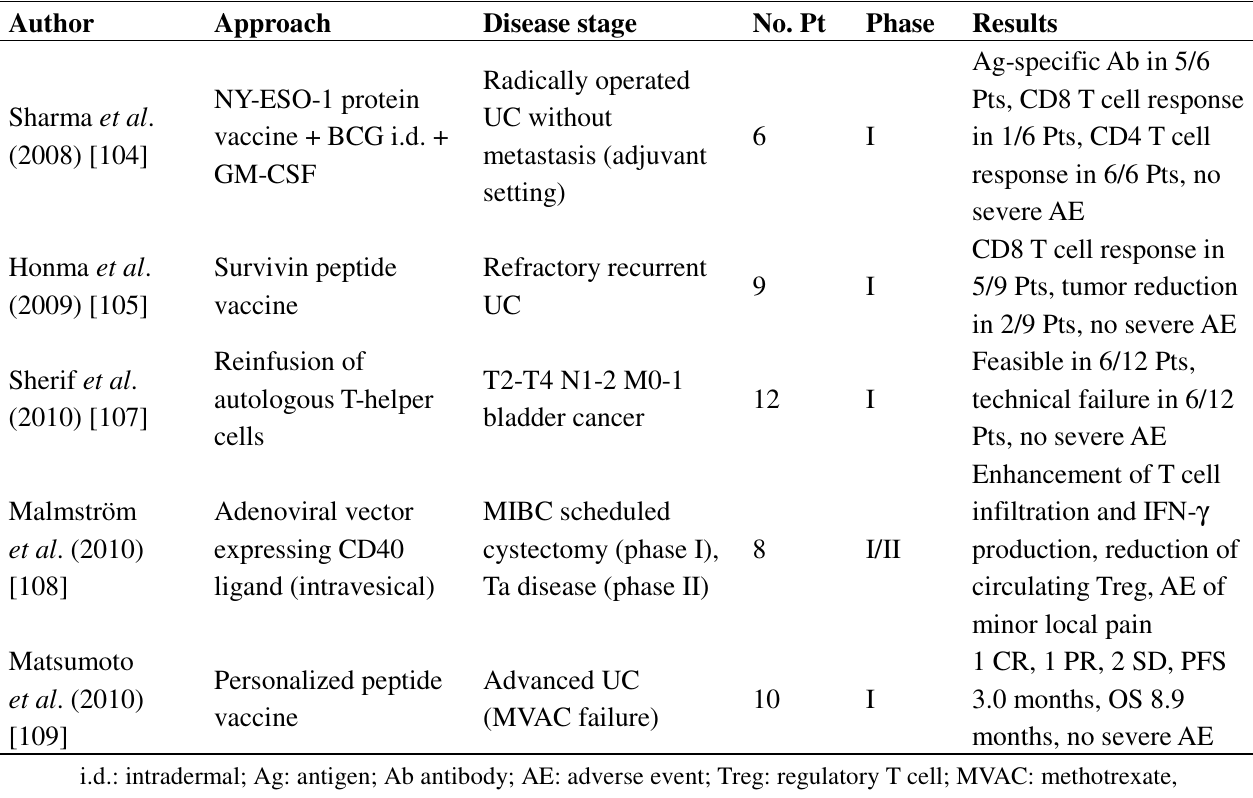
Table 1. Overview of phase I and II clinical trials of active immunotherapy in bladder